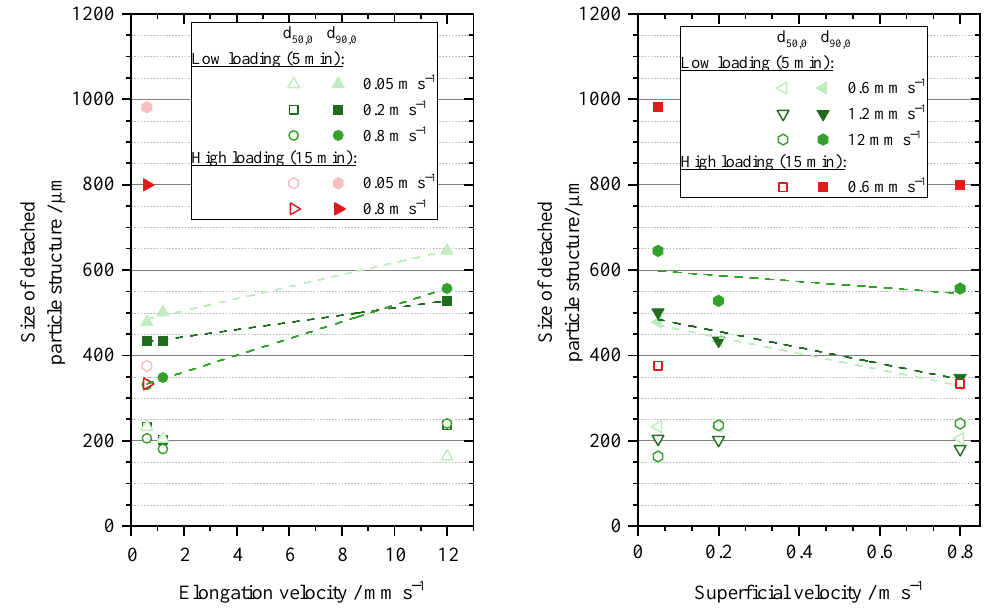
Figure 11. d 50,0 and d 90,0 values of detached particle structures as function of elongation velocity ( LEFT ) and superficial velocity ( RIGHT ). All structures detached within 5 cycles of fiber stretching with the given parameters. Linear fits of the development of d 90,0